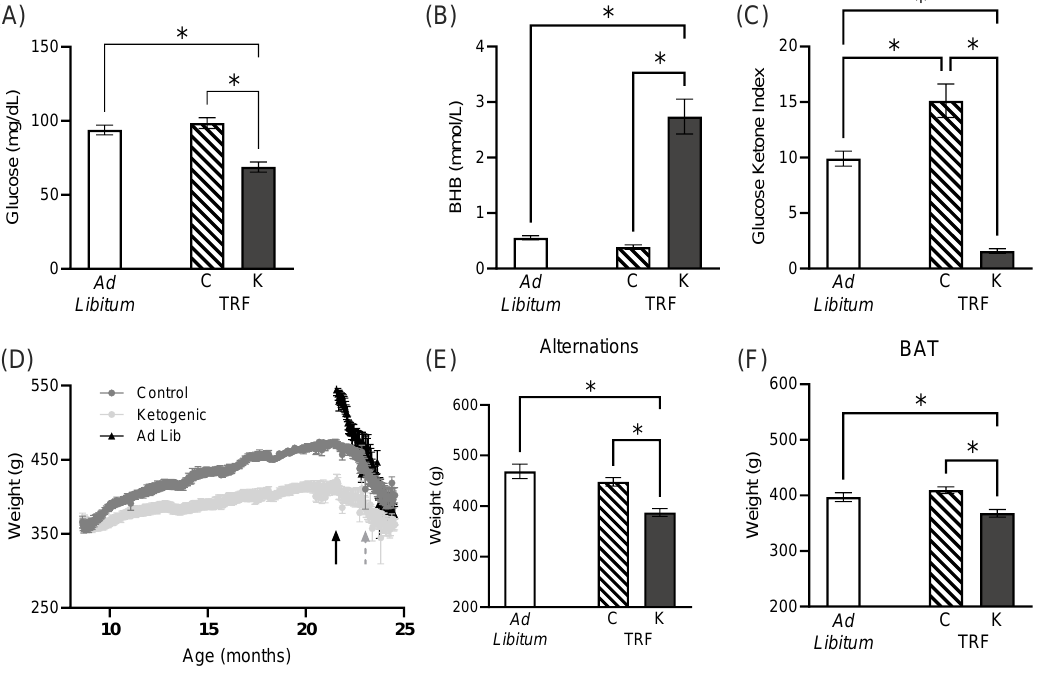
Figure 2. Postprandial glucose, BHB and GKI values and body weight. Only rats fed a ketogenic diet exhibited nutritional ketosis as evidenced by ( A ) reduced glucose, ( B ) elevated levels of the ketone body β -hydroxybutyrate and ( C ) a lower glucose ketone index (GKI). ( D ) Body weights throughout the lifespan continued to increase while fed a ketogenic or control diet via time-restricted feeding, until the onset of further dietary restriction (solid black arrow) and during BAT testing (beginning at dashed gray arrow). Body weight on the first day of ( E ) alternation training, as well as ( F ) BAT, was significantly lower in ketogenic diet-fed rats relative to both other groups. C, control-fed; K, ketogenic diet-fed; TRF, time restricted-fed; BAT, biconditional association task. All data are group means ± 1 SEM; * indicates p <